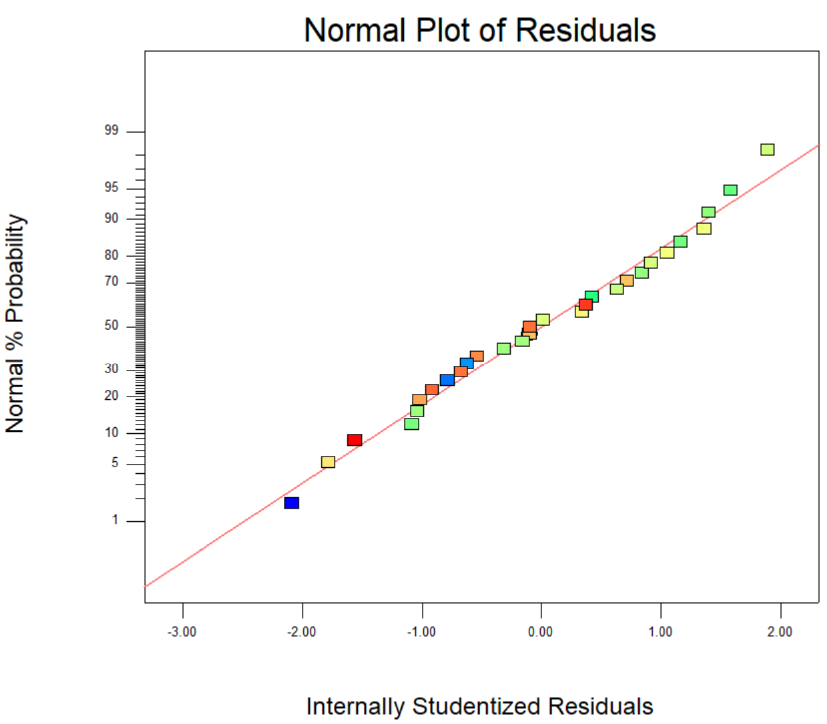
Figure 16. Normal probabilities and internal learning residuals.